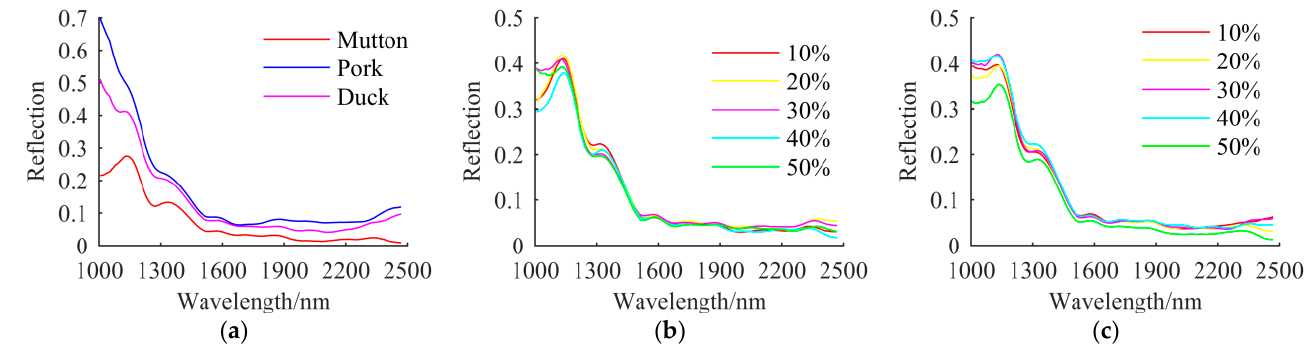
Figure 4. Mean reflectance spectrum of ( a ) pure meat; ( b ) adulterated samples at different percentages with pork; ( c ) adulterated samples at different percentages with duck meat.